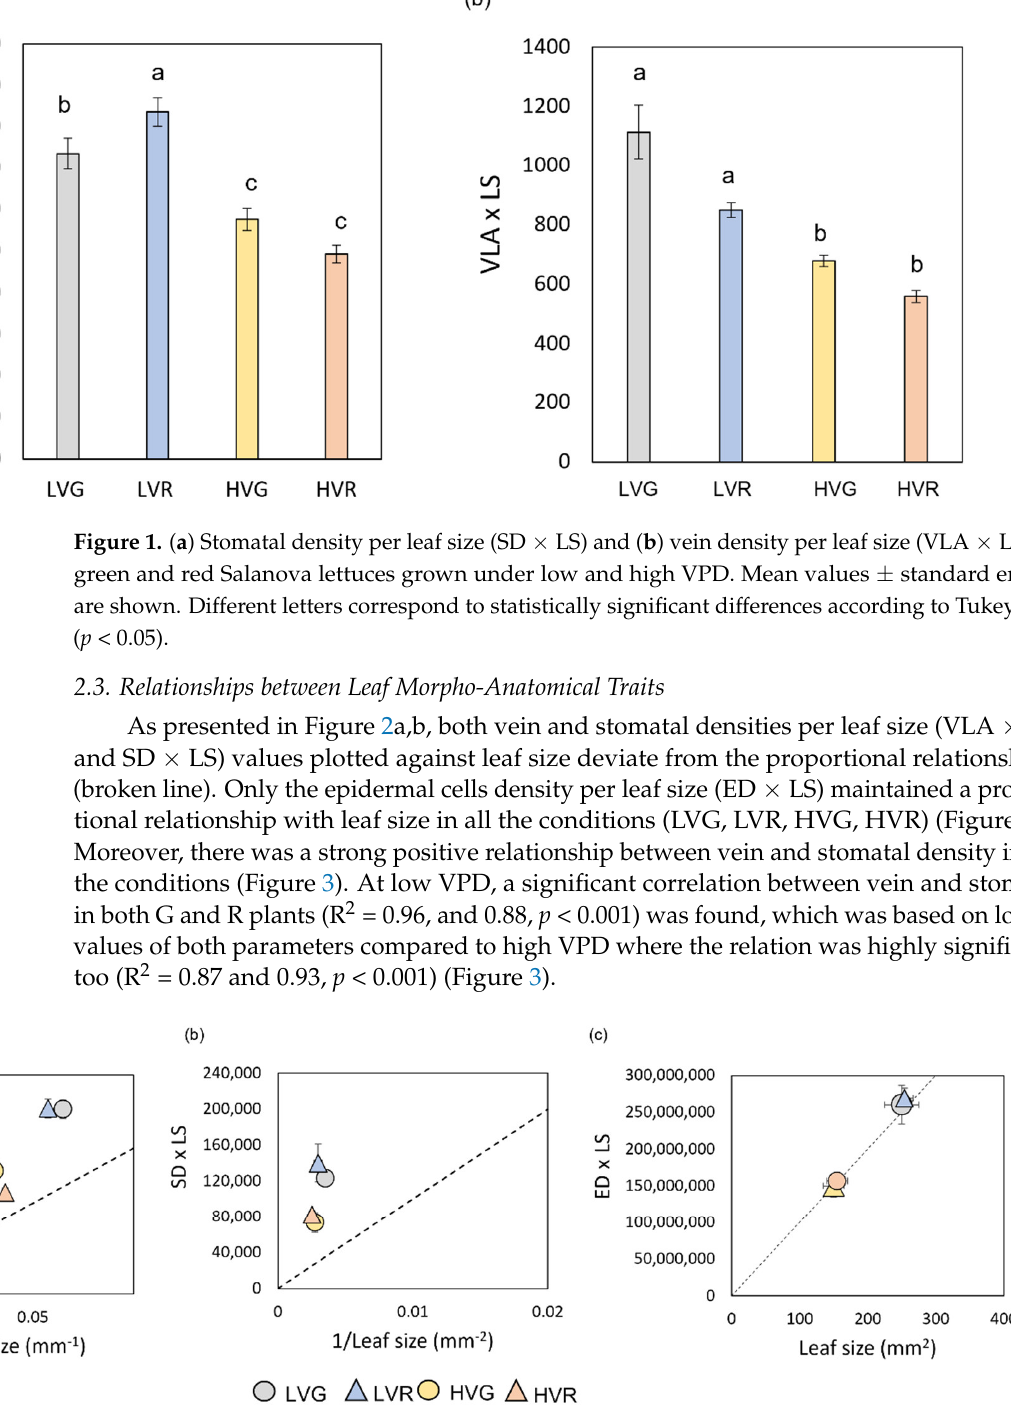
Figure 3. Vein density per leaf size (VLA × LS) and stomatal density per leaf size (SD × LS) of grey (circles) and red (triangles) lettuces grown under low and high VPDs. Regression lines and R2 values are also shown. 2.4. VPD Influence on Stomatal and Vein Distributions within Leaves The distribution of veins and stomata within the lamina changed with the VPD, the cultivar and the position within the leaf (Tables 3 and 4). More specifically, VPD and position as main factors influenced SD, SL, FEV and VLA ( p < 0.001). Differently, the cultivar only influenced the vein traits ( p < 0.01). Concerning stomatal density (SD), highest values were found at the apex part of low VPD plants in both green and red cultivars (LVGa and LVRa), followed by the apex part of high VPD green and red plants (HVGa and HVRa) and then by the medium part of low VPD green and red plants (LVGm and LVRm), which in turn were higher than the medium part of high VPD green and red plants (HVGm and HVRm). The lowest values were found in high VPD green and red plants at the bottom part (HVGb and HVRb). Alternatively, stomatal length (SL) showed an opposite trend, being higher under high VPD of both green and red plants at the bottom part (HVGb and HVRb), followed by high VPD green and red plant at the medium (HVGm, HVRm) and at the apex (HVGa and HVRa) parts (with no differences among them). The lowest values were found in low VPD of green and red plants at the apex part (LVGa and LVRa).